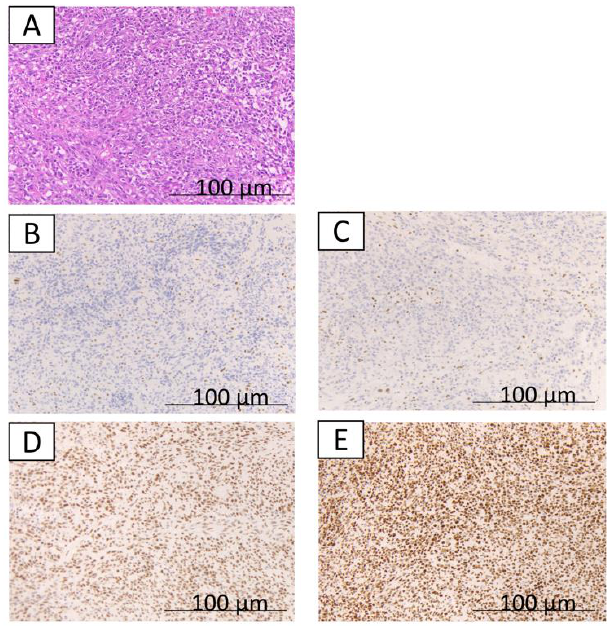
Figure 2. The immunohistochemical findings from case 1. A,B,C,D,E indicate a typical undifferentiated component; hematoxylin and eosin staining show the undifferentiated component ( A ); loss of expression of MLH1 ( B ); loss of expression of PMS2 ( C ); expression of MSH2 ( D ); expression of MSH6 ( E ).